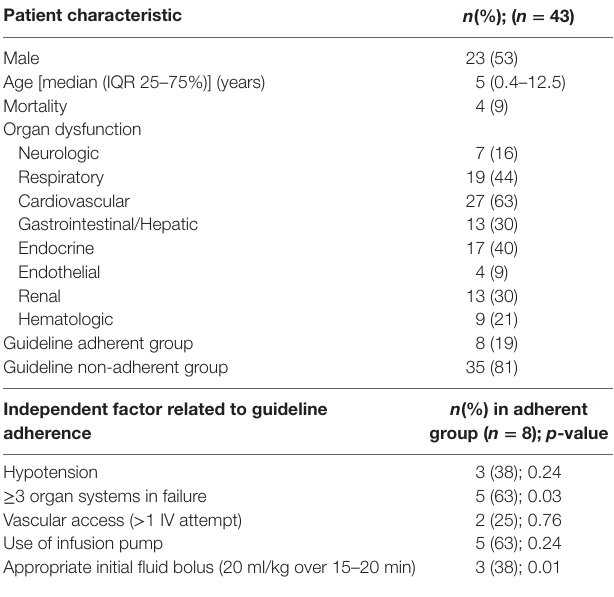
Table 1 | Patient